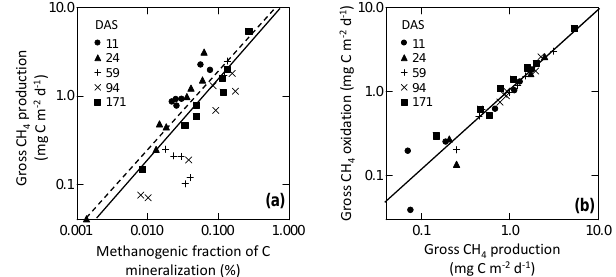
Figure 3. Gross N 2 O reduction rates versus (a) gross N 2 O pro- duction and (b) CO 2 efflux. Symbols represent sampling on dif- ferent days after seeding (DAS): circles are DAS 11, triangles are DAS 24, pluses are DAS 59, crosses are DAS 94, and squares are DAS 171. (a) The line represents the regression line for all sampling dates together, Log 10 (y) = [ 1 . 567 × log 10 (x) ]− 2 . 573 ( R 2 = 0 . 60, n = 39, p < 0 . 001), and (b) the line represents the regression line for sampling dates when the corn was not at peak growth (DAS 11, 24, and 171), Log 10 (y) = [3.663 × log 10 (x) ] + 0.822 ( R 2 = 0.80, n = 24, p< 0 . 001).